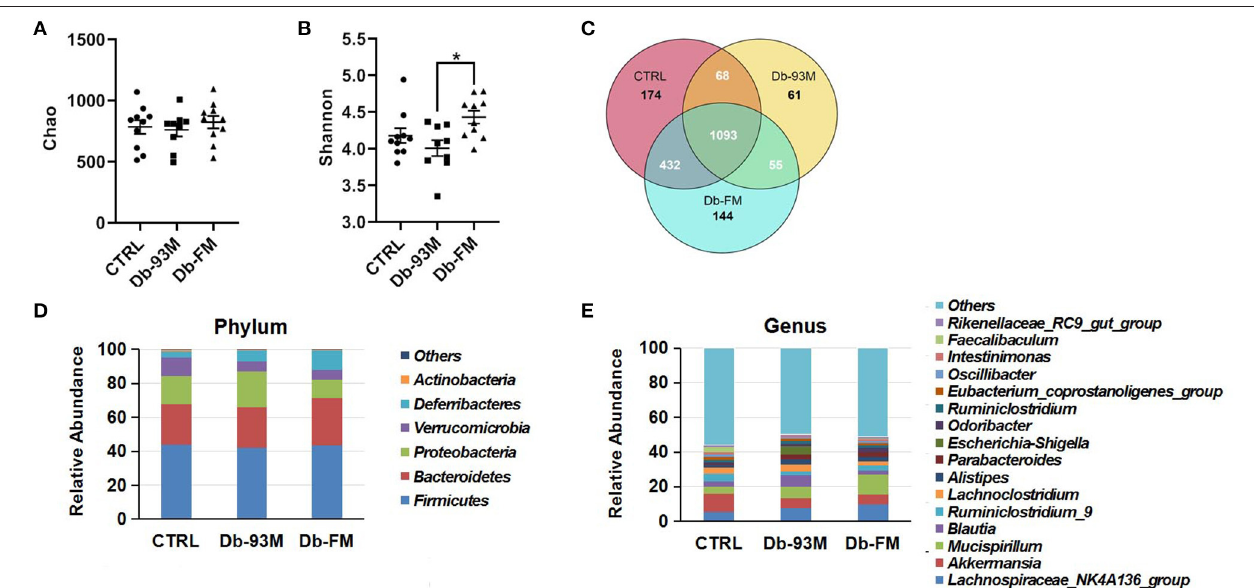
FIGURE 5 | The gut microbiota composition analysis. (A) The microbial richness index of Chao. (B) The microbial diversity index of Shannon. (C) Venn diagrams that illustrated observed overlap of OTUs from different groups. (D) The composition of gut microbiota in mice at phylum level. (E) The composition of gut microbiota in mice at the genus level. “Others” represent the sum of all the phyla/genera, which abundances were under 1%. Data are expressed as the mean ± SEM.